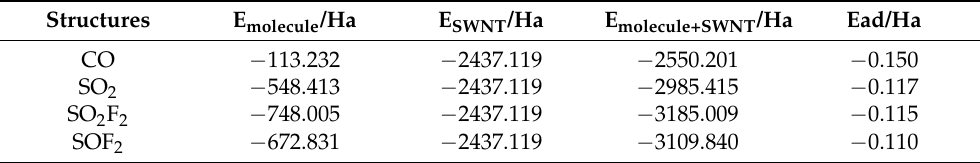
Table 2. Adsorption energies of four gas molecules on single-walled carbon nanotubes.